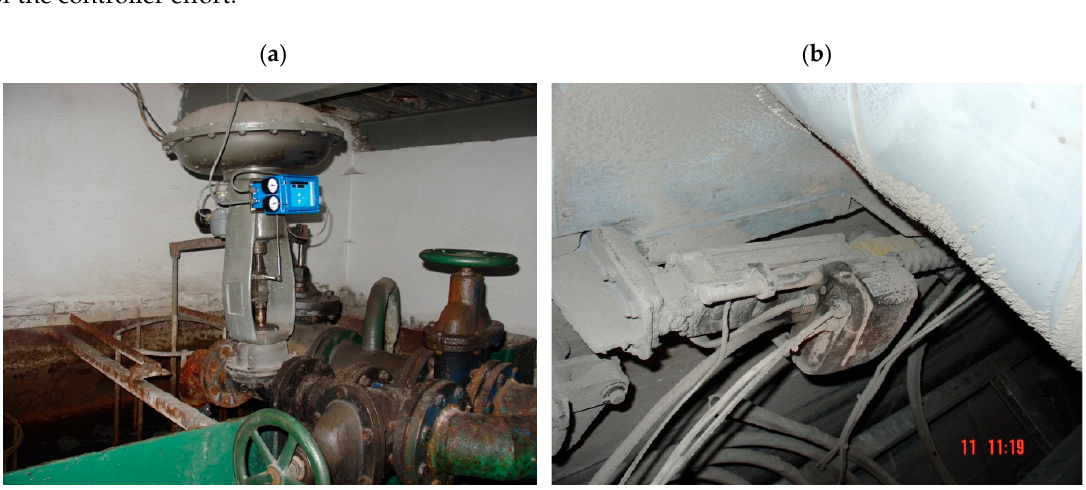
Figure 13. ( a ) Snap shot of the final control element installed in the liquid level control loop. The effects of a highly corrosive environment are visible by naked eye. The ambient temperature varies in the range 15–50°C, while relative humidity in the range 50–95%; ( b ) An example of the application of the positioner for the control of air to fuel ratio in one of the black coal power stations. The final control element has been installed in extremely hot and dusty environments.